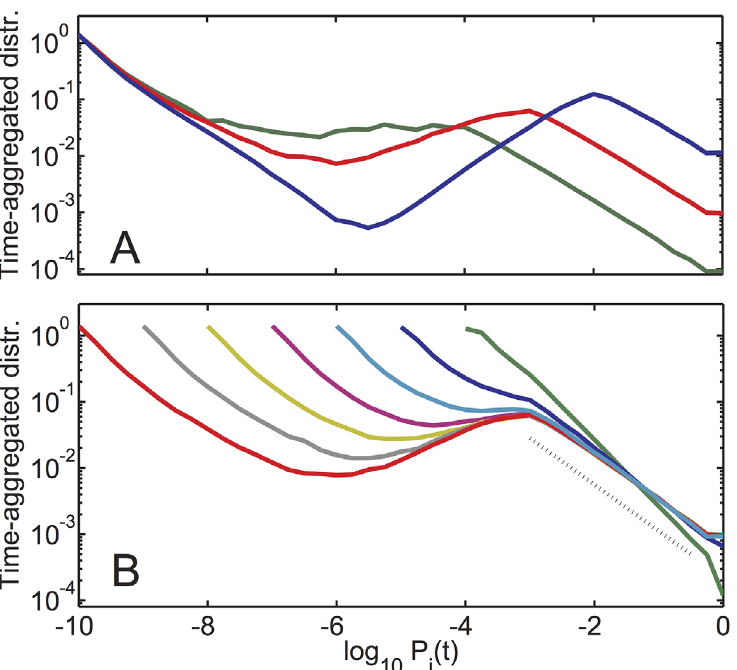
Fig 4. Time-aggregated distributions for different values of N and γ . Time-aggregated distributions of population sizes in our model with A) γ = 10 − 10 and N = 100 (blue), N = 1000 (red), and N = 10,000 (green). B) N = 1000 and varying γ ranging between 10 − 4 (green) to 10 − 10 (red) in ten-fold decrements. Note the emergence of a nearly universal scale-free tail of the distribution fitted with τ ’ 1.7 (dashed line).